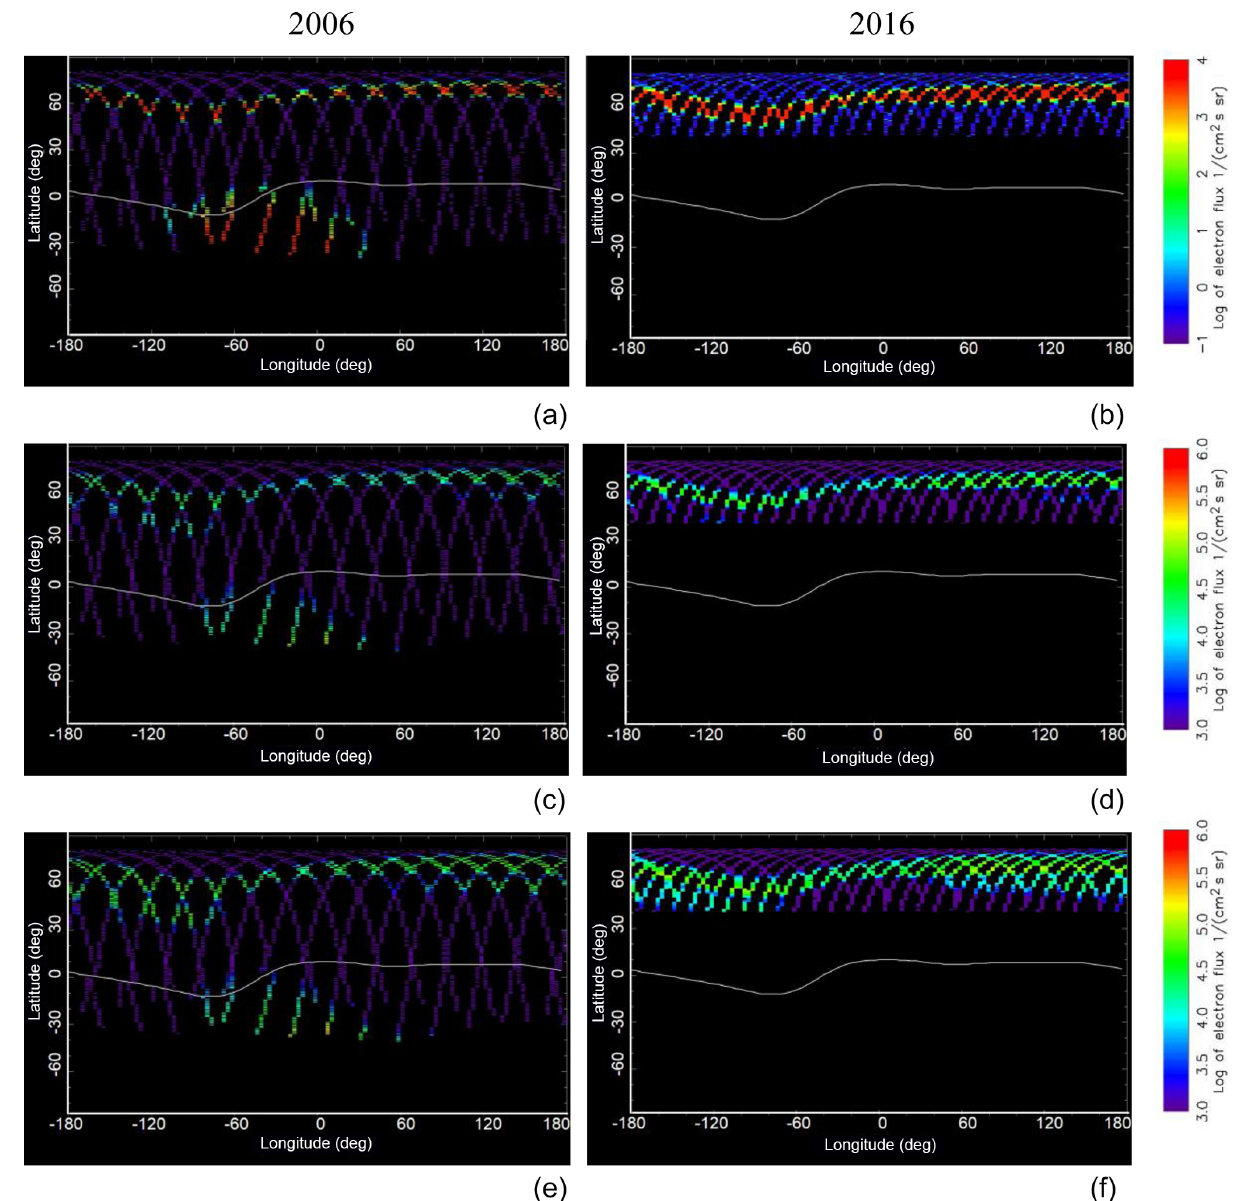
Figure 2. Geographic maps of energetic electron fluxes with energies >300 (a, b) , >100 (c, d) , > 30keV (e, f) and pitch angles of ∼ 90 ◦ observed by POES satellites at a height of ∼ 850km in the 2h vicinity of local noon (left column) on 23 June 2006 and (right column) on 2 June 2016. The solid wide curve indicates the geomagnetic Equator. The outer and inner electron belts and a slot region between them are clearly seen (except for >300keV electrons), respectively, at high and middle latitudes in the longitudinal range from ∼ 90 ◦ E to ∼ 80 ◦